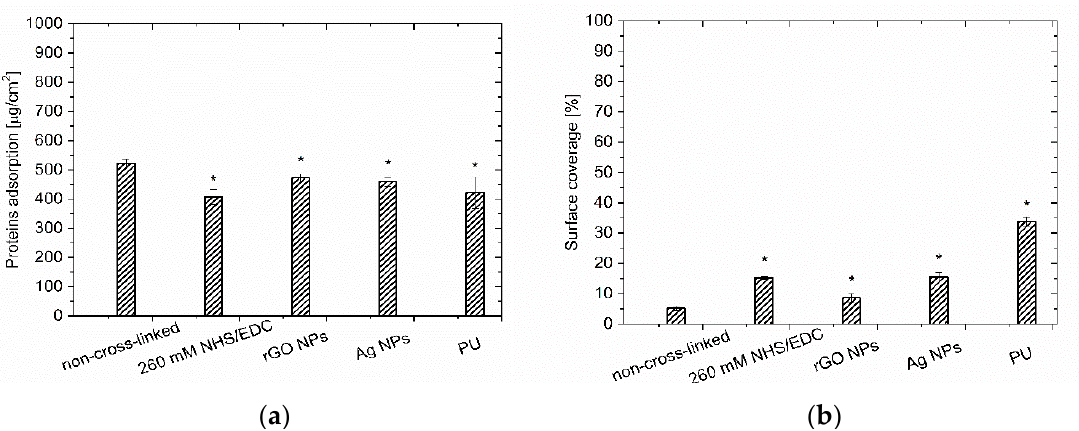
Figure 5. ( a ) Amount of adsorbed proteins and its effect on ( b ) surface coverage of Chi/CS film unmodified, cross-linked with 260 mM NHS/EDC and modified by reduced graphene oxide flakes and silver nanoparticles by blood morphotic elements. Data represent mean ± SD, n = 8; * p < 0.05 vs. non-cross-linked sample.